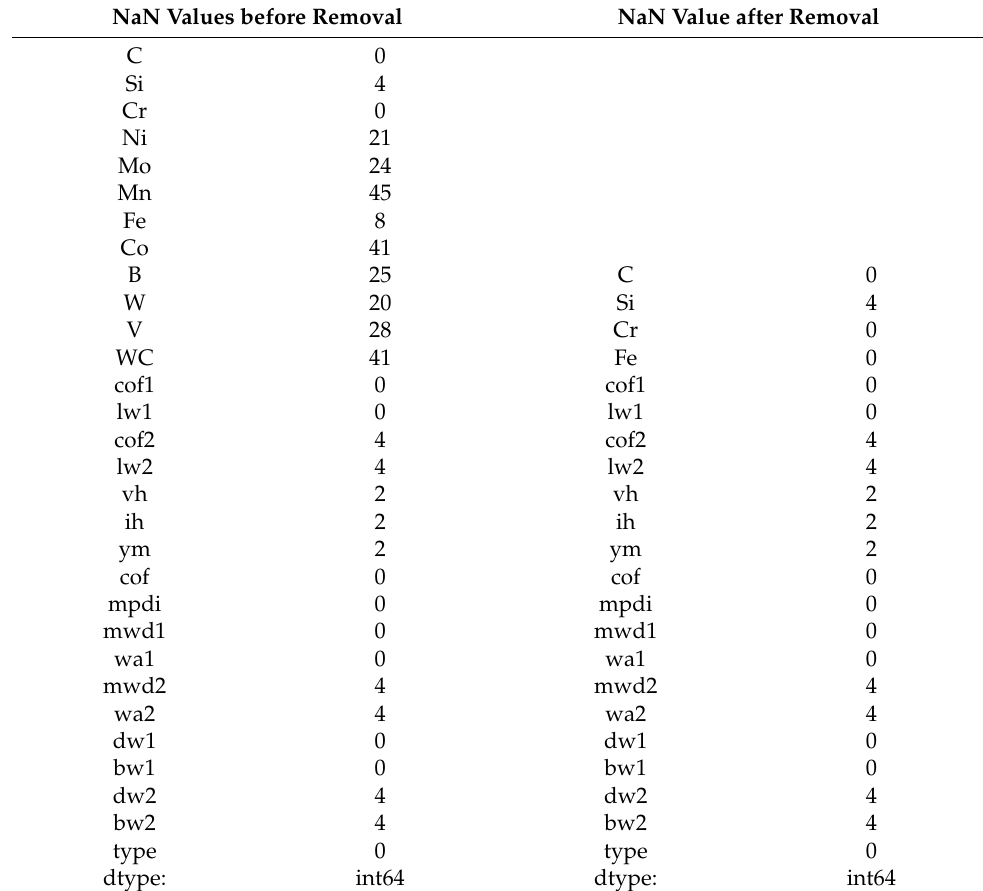
Table 3. Analysis of NaN values, before and after the removal of selected